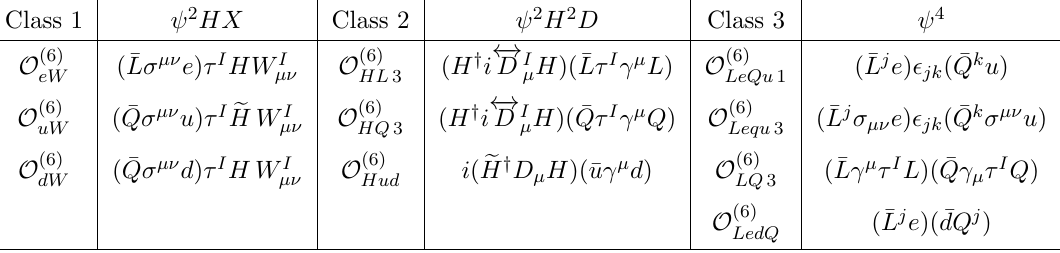
Table 1 . LNC dim-6 operators [86] involving active neutrinos that a(cid:11)ect 0 (cid:23)(cid:12)(cid:12) at tree level.